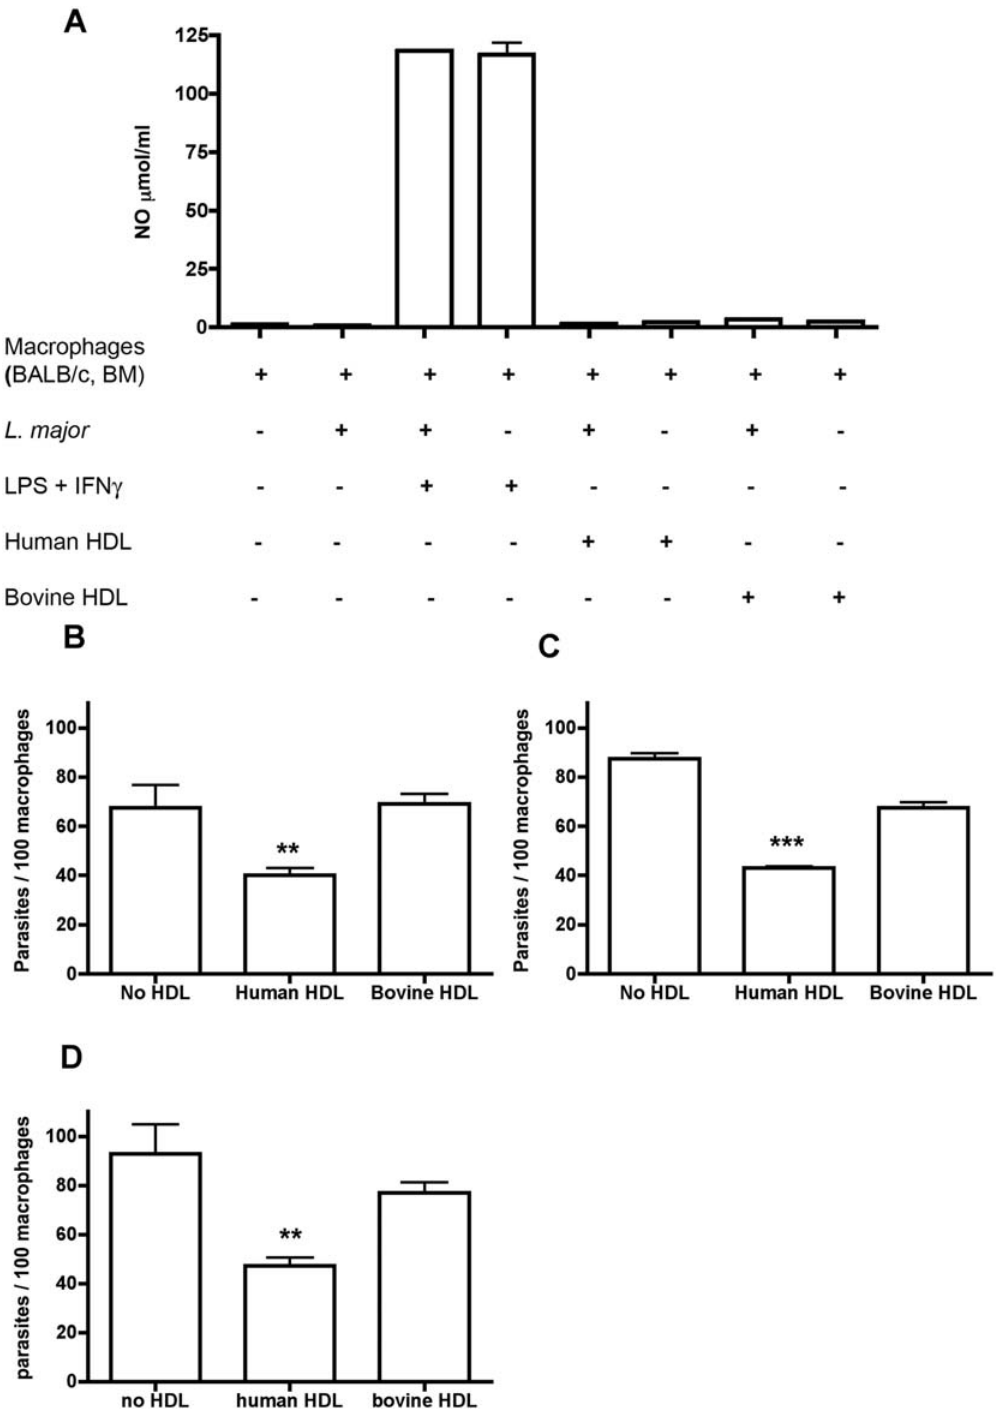
Figure 6. Lytic HDL does not generate NO nor requires the activation of macrophages to reduce the parasite burden. BALB/c bone- marrow derived macrophages were infected with L. major metacyclics at a multiplicity of infection of 3:1, for 2 hours before the addition of bovine or human HDL (1.5 mg/ml) or treated with IFN c and LPS; NO production in the supernatant was measured after 24 hours (A). Bone marrow derived macrophages from iNOS 2 / 2 (B), gp91phox 2 / 2 (C), or C57BL/6 (D) mice were infected with L. major metacyclics at a multiplicity of infection of 3:1, for 2 hours, before the addition of human or bovine HDL (1.5 mg/ml). They were co-incubated for 24 hours. The data represent the mean 6 standard deviation (SD) of duplicate cultures of one typical experiment that has been repeated twice. ** p , 0.001, *** p , 0.0001 compared to bovine HDL, ANOVA test.